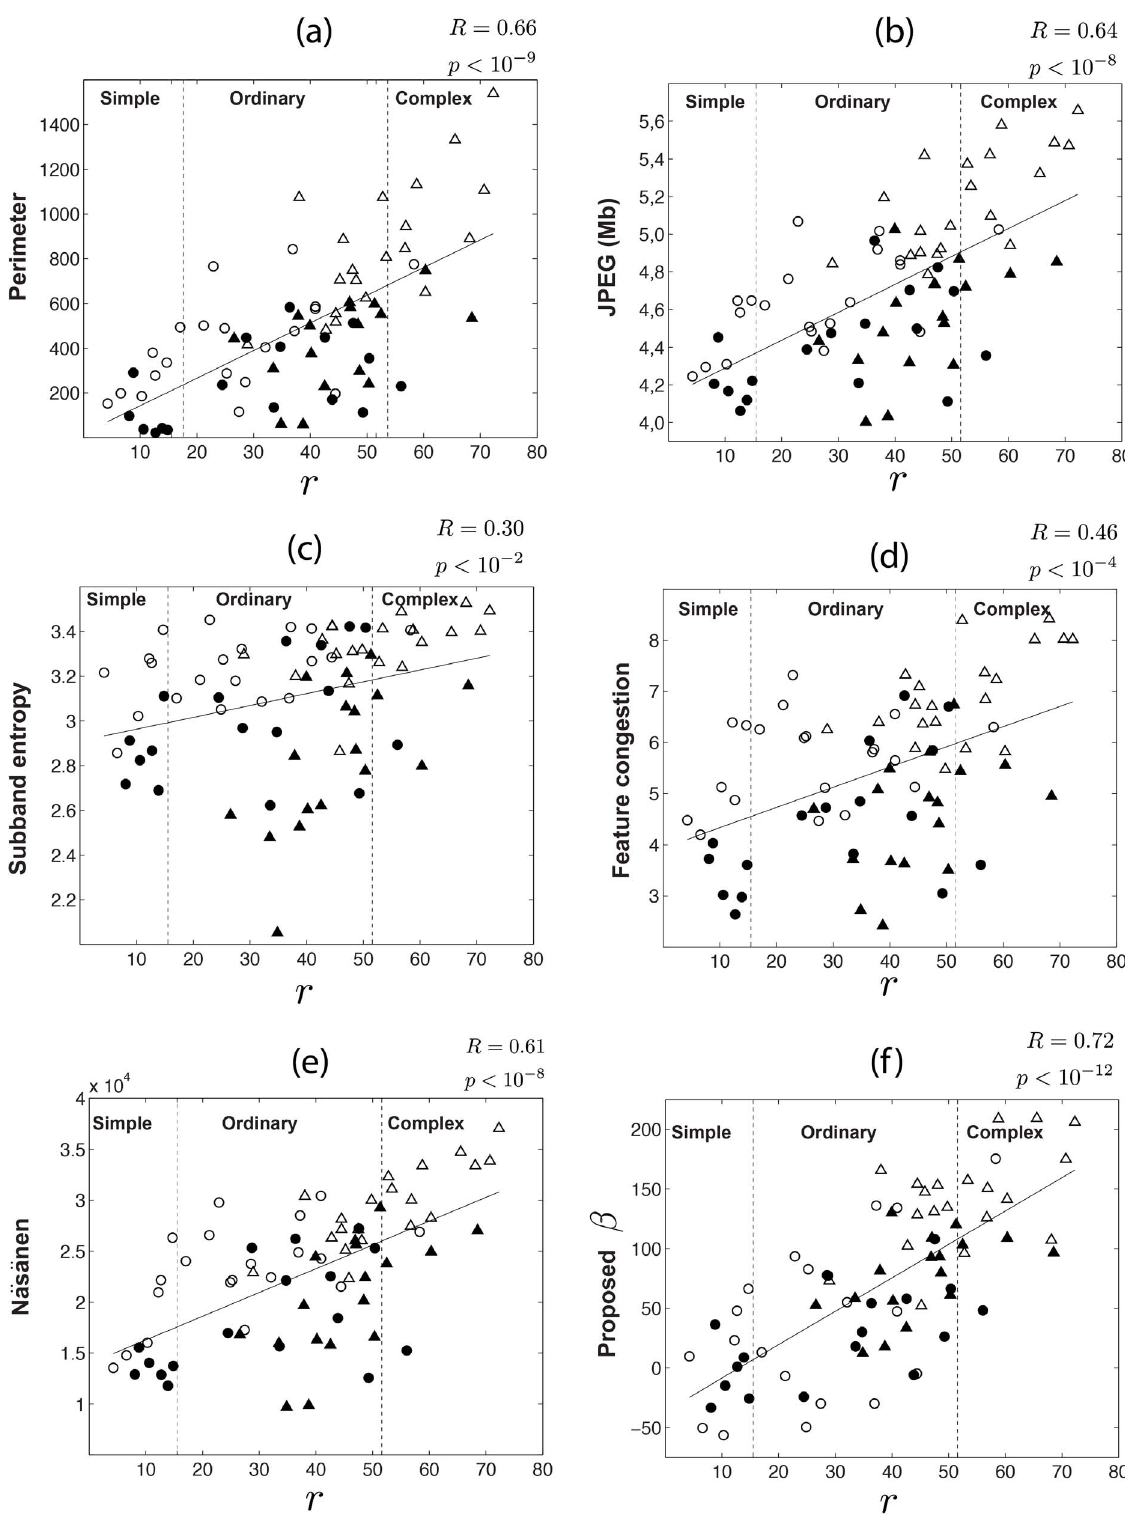
Figure 10. Correlation between objective measures and subjective rank. Objective measures are given in function of subjective rank r . (a) Perimeter length. (b) JPEG file size given in megabytes . (c) Subband entropy. (d) Feature Congestion. (e) Nasanen. (f) Measure b . Correlation coefficient between objective and subjective ranks are given at the top right corner of each plot. Vertical dotted lines represents the divisions between categories simple , ordinary and complex . In each scatter plot, the solid line represents the best least-squares-sense first-order polynomial fit.